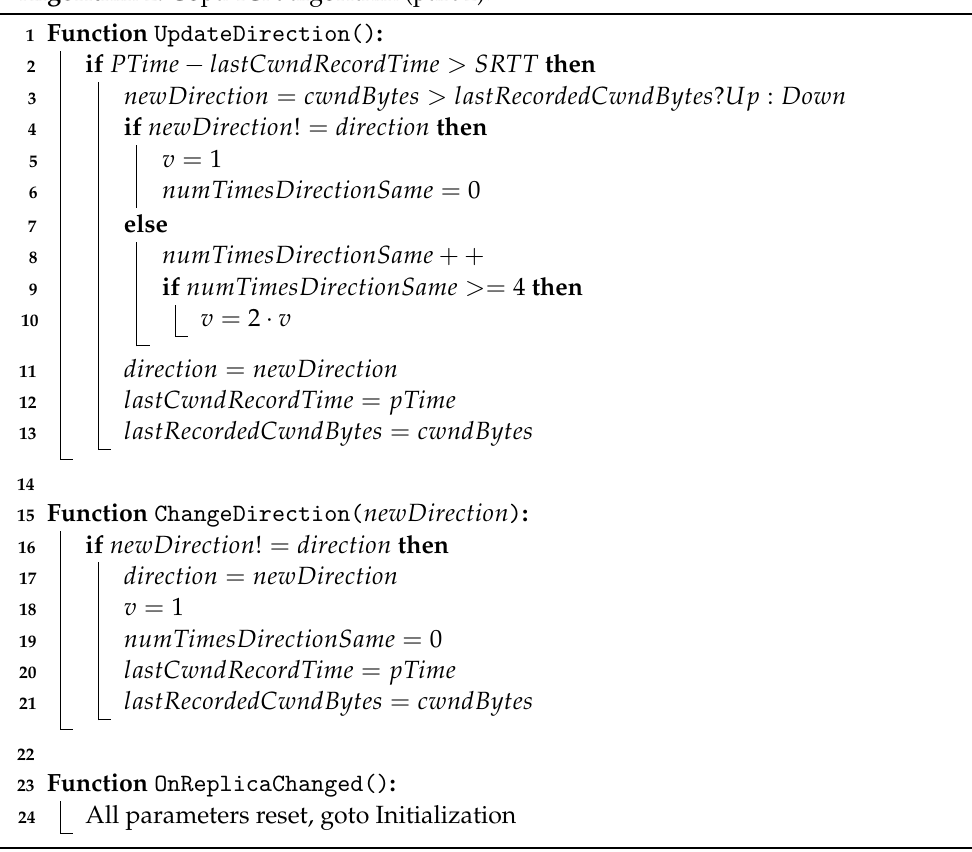
Algorithm 2: Copa-ICN algorithm (part